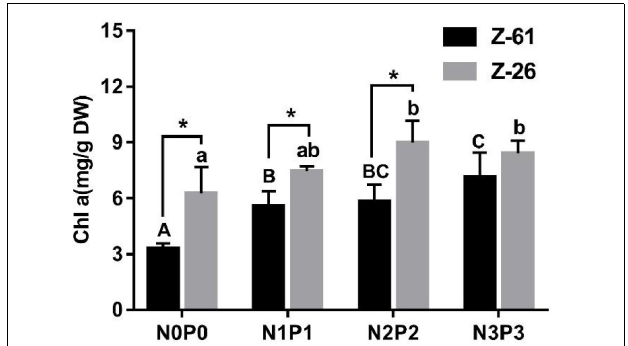
FIGURE 2 | Chlorophyll a (Chl a ) content of Z-61 (black bars) and Z-26 (gray bars) cultured under four different nutrient conditions. From N0P0 to N3P3, the NO 3 − contents were 0.61, 1.81, 5.29, and 13.16 mg/L, while the PO 43 − contents were 0.09, 0.19, 0.65 and 1.34 mg/L, respectively. Different letters represent significant differences ( P < 0.05) among treatments (lowercase for Z-26 and capitalized for Z-61). * indicates significant difference between Z-61 and Z-26. Values are means ± SD ( n = 4). DW: dry